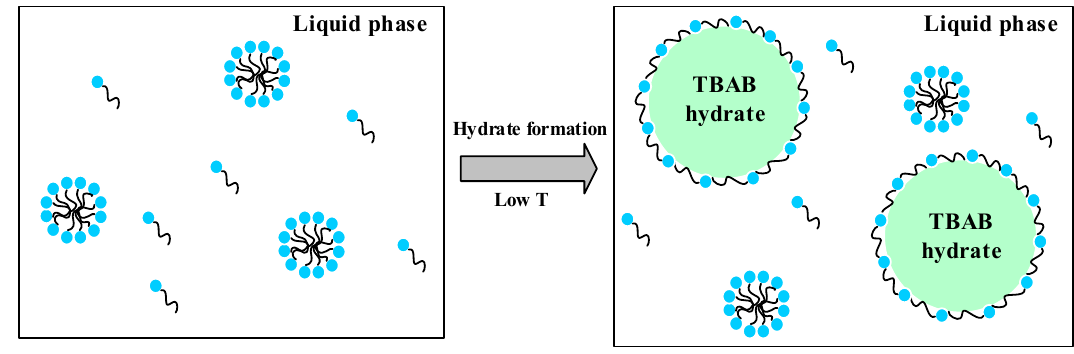
Figure 4. Micrographs of TBAB hydrate.